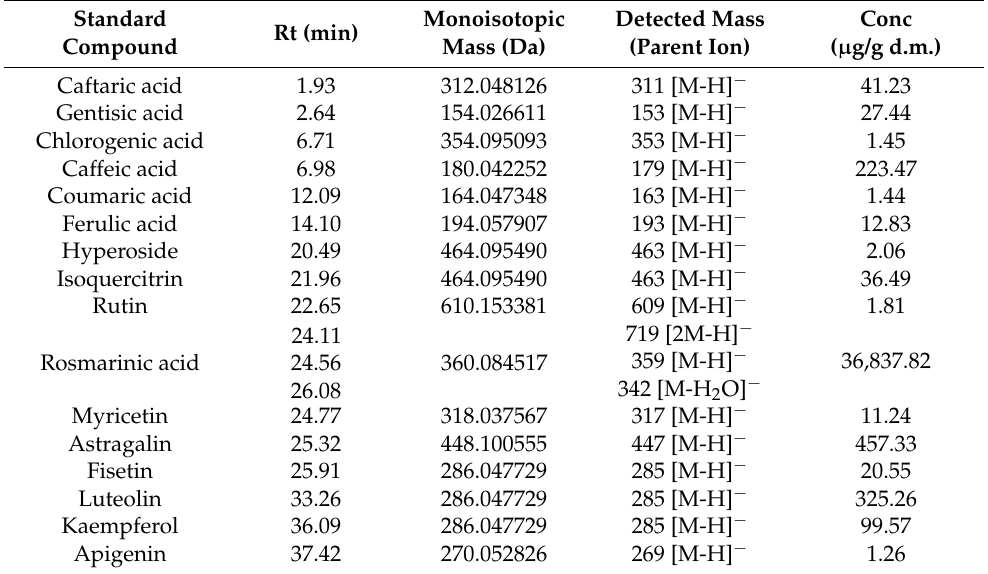
Table 2. The main phenolic compounds identified in Melissa officinalis total extract by LC-MS.